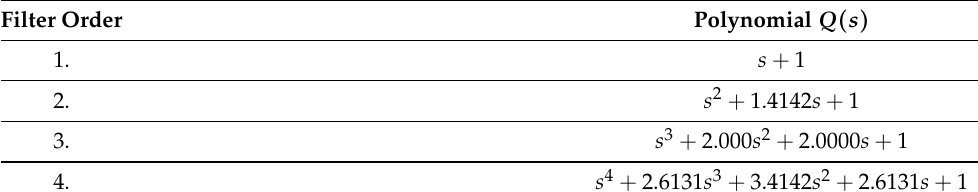
Table 1. Normalized Butterworth polynomials [33]. Filter